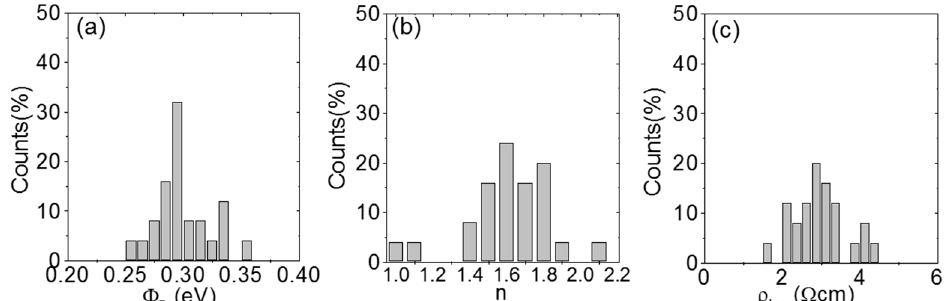
Figure 3. Histograms of the local Schottky barrier height Φ B ( a ), ideality factor n ( b ), and resistivity ρ loc ( c ) extracted from the array of I - V tip characteristics in Figure 2b. Figures adapted with permission from Reference [44], copyright from the American Physical Society